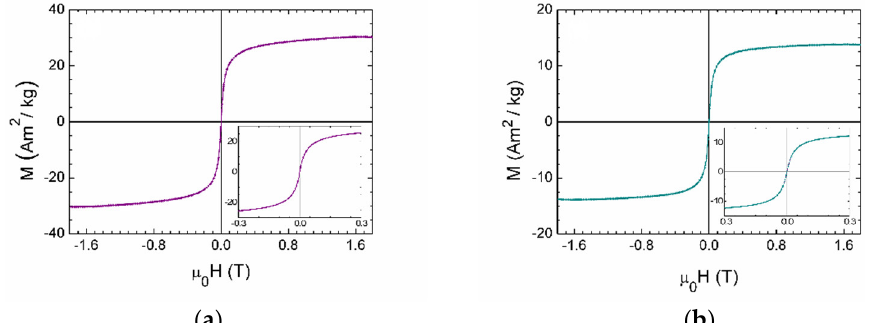
Figure 10. ( a ) Magnetization cycle of SPIONs; ( b ) magnetization cycle of MOLNBs. In the insets, a zoom of the measurements is reported, highlighting the superparamagnetic behavior of the sam- ples (i.e., absence of magnetic hysteresis and remanence). (i.e., absence of magnetic hysteresis and remanence).